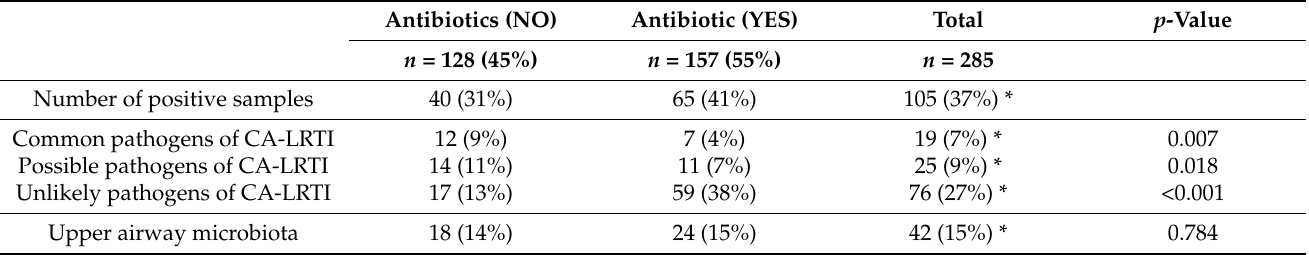
Table 3. Detected pathogens: relation to antibiotic treatment within one month before